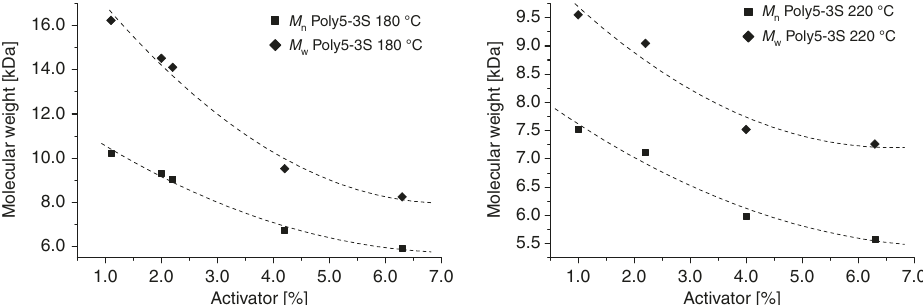
Fig. 4 Polymerization of 5-3S. Effect of the reaction temperature and the activator concentration on M n and M w (Supplementary Figs. 8 and 9, Supplementary Table 11). Conditions: 1.8 mmol 5-3S , 2.0 – 5.5 mol% NaH on paraf fi n, 180 or 220 °C, 1 h. Molecular weights refer to masses over 1.0 kDa (GPC).